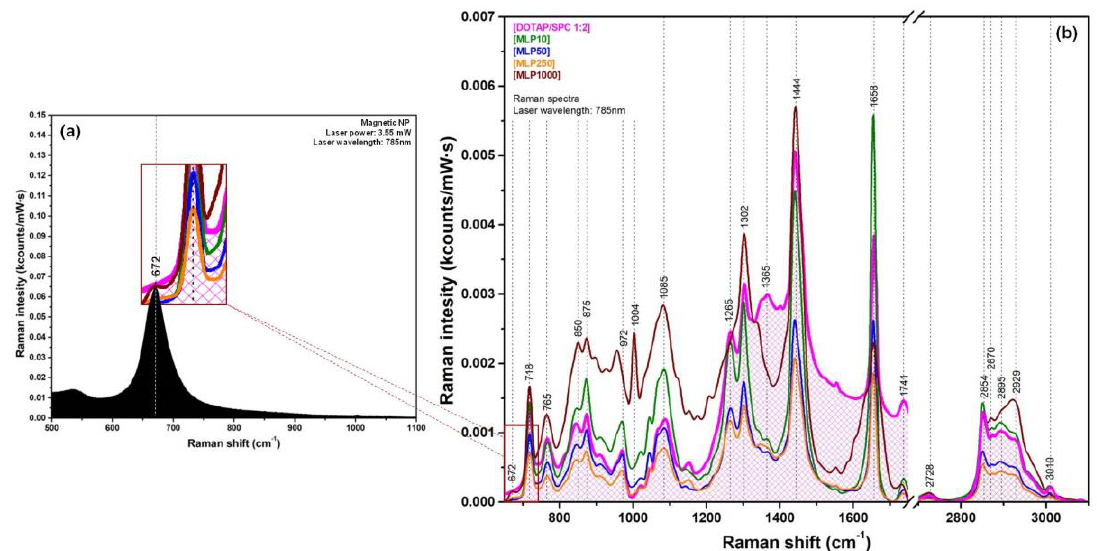
Figure 6. ( a ) The black Raman spectrum was recorded of the SPION powder. ( b ) Superposition of the Raman spectra recorded of pure (unloaded) liposomes (magenta curve) with those recorded of the four classes of MLPs.